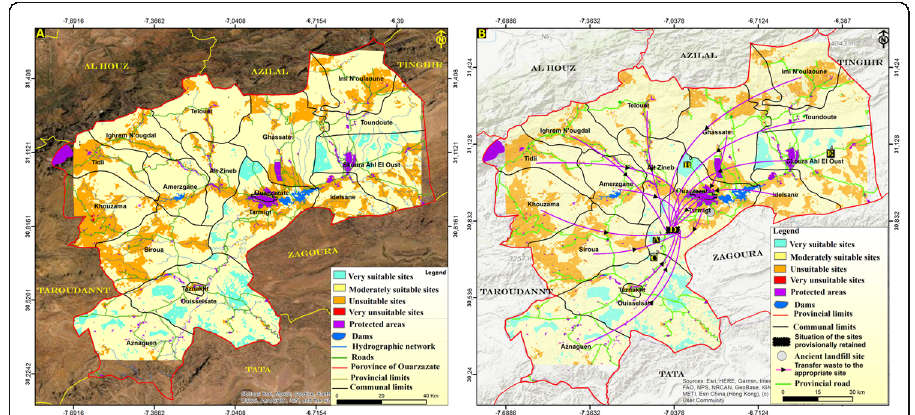
Fig. 12 Overlay of the raster data of the